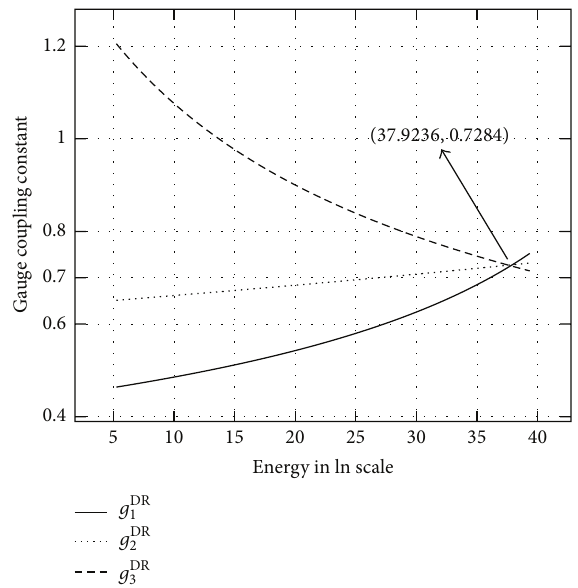
Figure 2: Gauge coupling unification for 𝑚 𝑠 = 𝑚 𝑡 = 173 . 5 GeV, (𝑒 37 . 9236 = 2 . 9515 × 10 16 ) GeV.